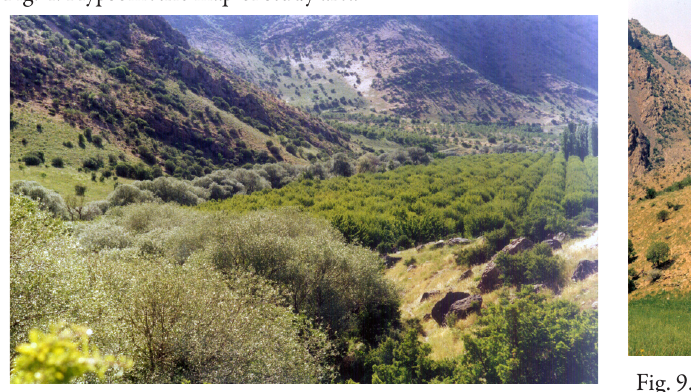
Fig. 4. Hypsometric map of study area